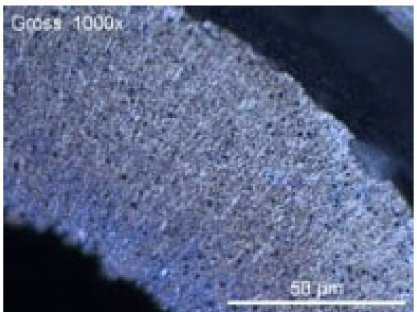
Figure 11. Microstructure of hypotube #8(ref): transverse surface (scale = 50 µ m).